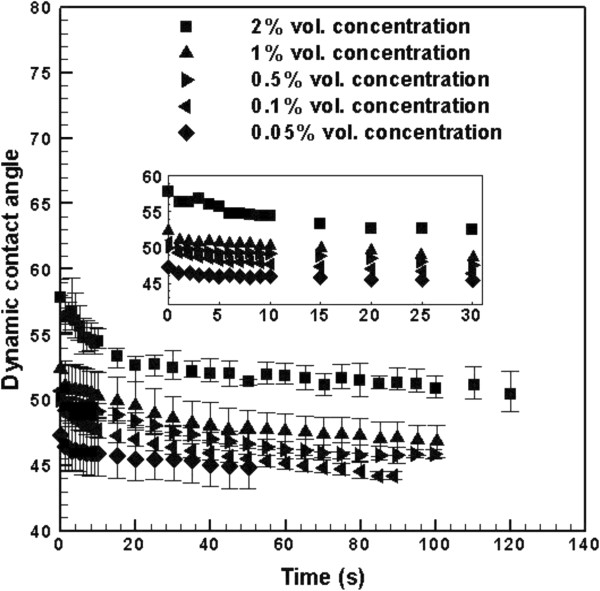
Dynamic contact angle of TiO2-DI water solutions.